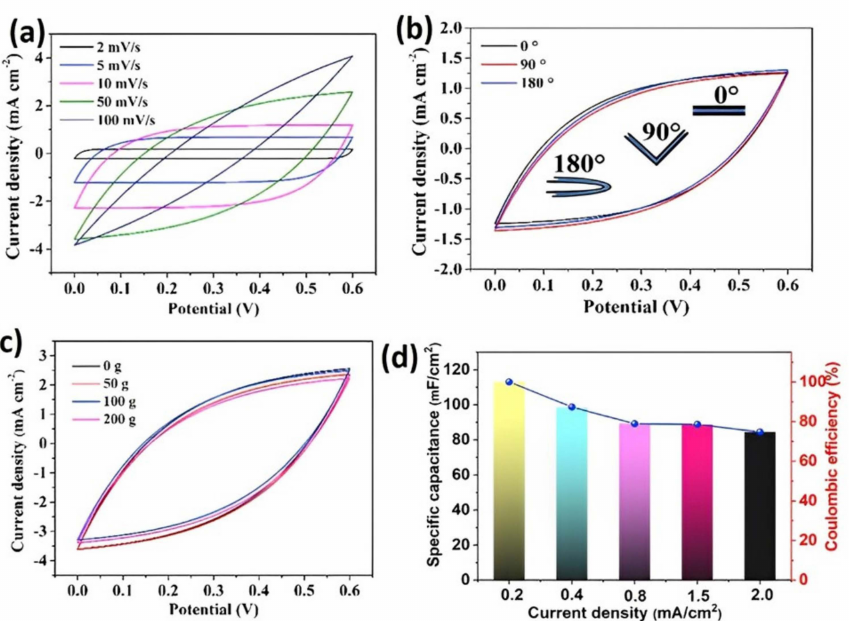
Figure 9. Electrochemical performances of MXene-based hydrogels using PVA/carboxymethyl cellulose film electrolyte. ( a ) Cyclic voltammetry curves at various scan rates; ( b ) cyclic voltammetry curves at various bending angels at a scan rate of 10 mV/s; ( c ) cyclic voltammetry curves at a scan rate of 10 mV/s; ( d ) capacitance at various current densities. Re-printed with permission under